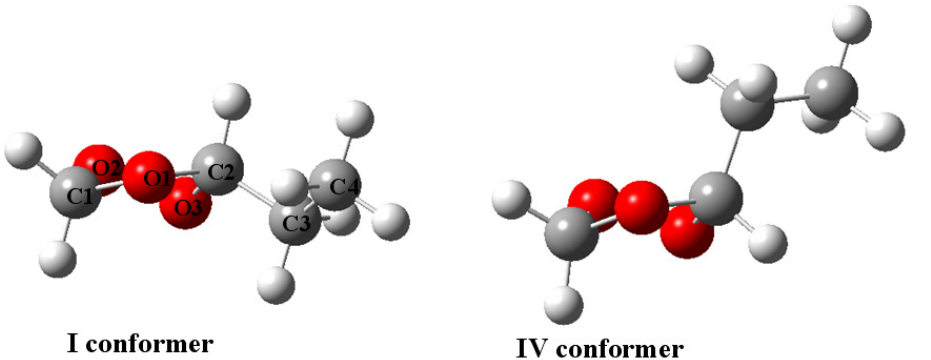
Figure 1. Theoretically (B3LYP \6-311++G(3df, 3pd)) calculated structures of an equatorial conformer I and axial conformer IV of 1-butene SOZ (for notation see Table 1). Table 1. DFT calculated (B3LYP \6-311++G(3df, 3pd)) relative heats of formation ∆ H of the six 1-butene SOZ conformers.